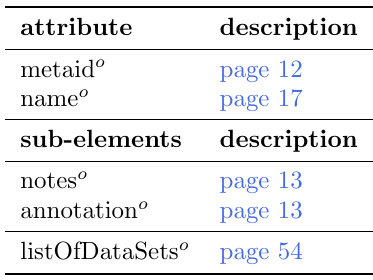
Table 2.24: Attributes and nested elements for report. o denotes optional elements and attributes.